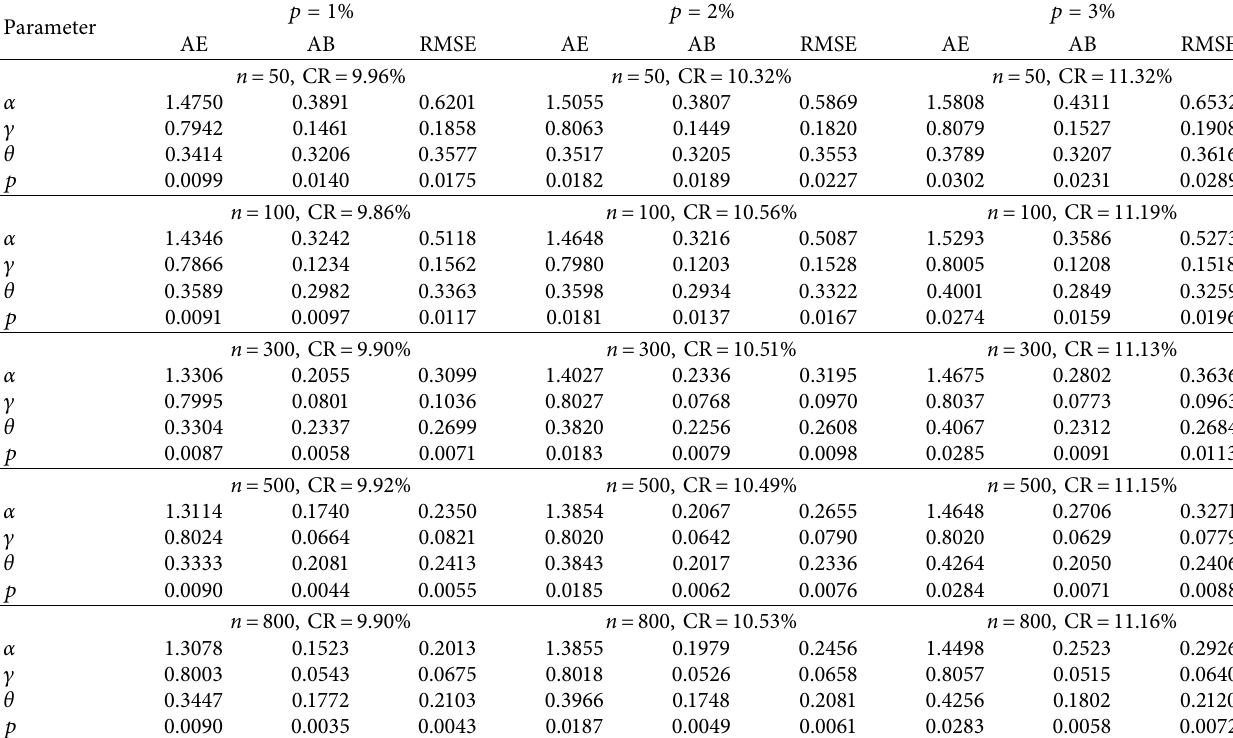
Table 2: Simulation results of SWGII distribution for parameter values ( α , c , θ ) � ( 1 . 2 , 0 . 8 , 0 . 3 )